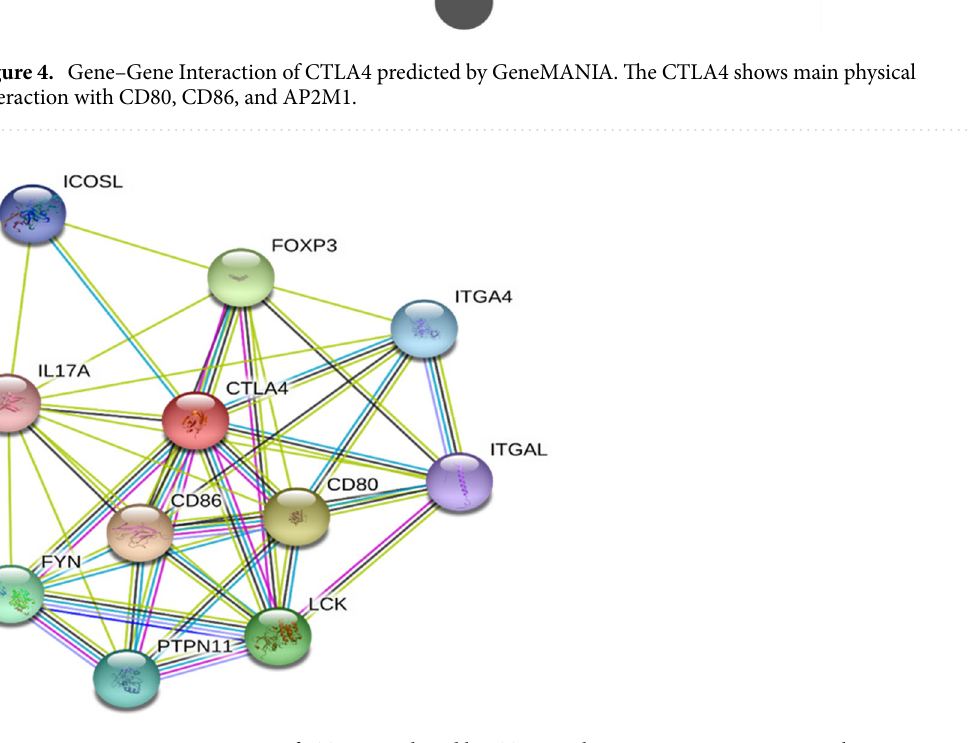
Figure 5. Gene–Gene interaction of CTLA4 predicted by STRING showing major interaction with CD80, CD86, and